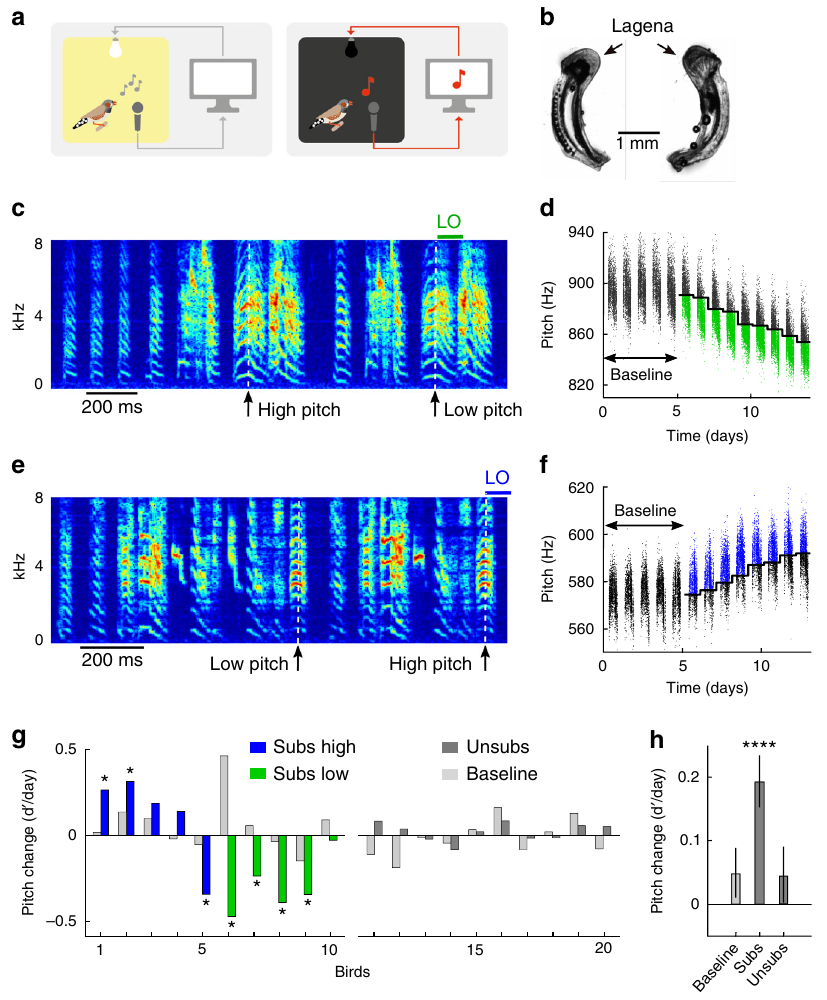
Fig. 1 Light-off stimuli are positive reinforcers of vocal pitch in deaf songbirds. a Schematic of the experiment. A singing deaf bird inside a sound- isolation chamber (left) experiences a light-off (LO) stimulus for a duration in the range of 100 – 500 ms (right) when the pitch of one of its song syllables (red note) exceeds a given threshold (Credit: Sarah Steinbacher, MELS UZH). b Example picture of a pair of surgically removed cochleas. Complete deafness was con fi rmed by the presence of the osseous spiral lamina and by veri fi cation of an intact loop including the lagena. c , e Example song spectrograms in birds b2y2 ( c ) and b2p19 ( e ) with substituted feedback for low-pitched ( c ) and high-pitched ( e ) syllable renditions. The time points of pitch measurement are indicated by white dashed lines and the LO stimuli by green ( c ) and blue ( e ) bars. d , f Pitch values for syllable renditions without substitution (black dots) and with substitution (green dots: low-pitch subs, d ); blue dots: high-pitch subs, ( f )). The birds adapted the pitch in the direction of increasing LO rate. g Histograms of average daily pitch changes during substitution in birds with high-pitch substitution (subs high, blue, n = 5 birds, the fi rst bar corresponds to b2p19 shown in ( e ) and ( f )), low-pitch substitution (subs low, green, n = 5 birds, the 8 th bar corresponds to b2y2 shown in ( c ) and ( d )), and in deaf control birds without substitution (unsubs, dark gray, n = 10 birds). The light gray bar to the left of each colored bar indicates the average daily pitch change in that bird during the last 5 baseline days. The asterisks indicate subs birds with signi fi cant pitch changes compared to controls (two- sample, two-sided t -test, p < 0.05). h Subs birds, as a population, adapt pitch in the direction of substituted feedback. Shown are the three fi xed-effect terms of a mixed linear-effect model and their standard errors (282 observations from n = 10 subs and n = 10 unsubs birds). The bars indicate the daily change in pitch (d ’ /day) during baseline, during substitution in the direction of increasing light-off rate (subs, **** indicates nonzero fi xed effect 0.19 d ’ / day, p = 3.0 × 10 − 6 , SE = 0.04, tstat = 4.77, df = 279, con fi dence interval 0.11 – 0.27 d ’ /day, n = 20 birds), and in control (unsubs) Effects of substitution on singing rate . Valence inversion was deaf birds compared to hearing birds (difference 0.16 d ′ /day, p = 0.01, tstat = 2.73, df = 20, n = 12 hearing and n = 10 deaf birds, also signaled by the contrasting effects of LO on singing rates two-tailed t -test, Fig. 2f). Thus, visual feedback is much more (Fig. 4a). On the last three days of substitution, subs birds pro- salient when it substitutes auditory feedback in deaf animals than duced on average 291 more song motifs (average increase of 25%) when it is a supplemental feedback in hearing birds. than on the last three days of baseline, which deviated from their Although they responded to LO in opposite directions, deaf controls (unsubs) that sung on average 479 fewer song deaf and hearing birds similarly modi fi ed their songs only in motifs (average decrease of 34%, n = 10 subs and n = 12 unsubs a very narrow time window, their maximum adaptive pitch birds, p = 0.02, tstat = − 2.65, df = 20, two sample two-tailed changes were mainly con fi ned to within roughly 10 ms of the t -test, 97% of random matchings resulted in a signi fi cant p -value). targeted time window for LO delivery, Fig. 3 and Supplemen- By contrast, hearing birds were oppositely but less affected by tary Fig. 2. light off: LO birds produced 310 fewer song motifs on the last